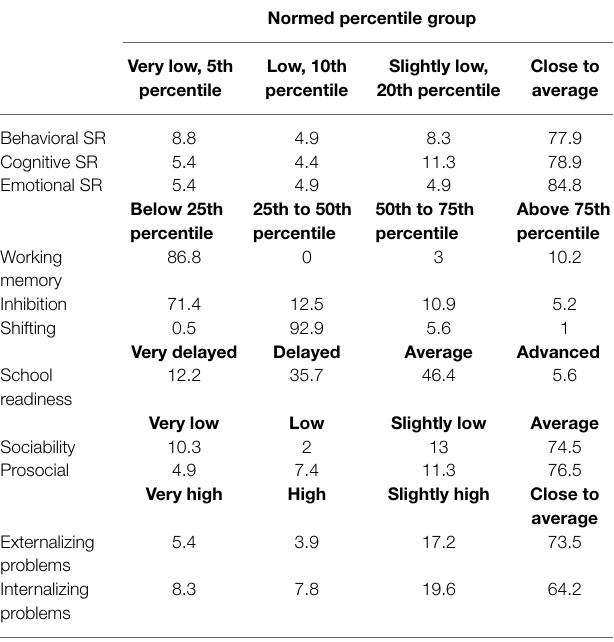
TABLE 1 | Percentage of sample in each of normed percentile groups for EF, SR, and outcome measures where norms available. Normed percentile